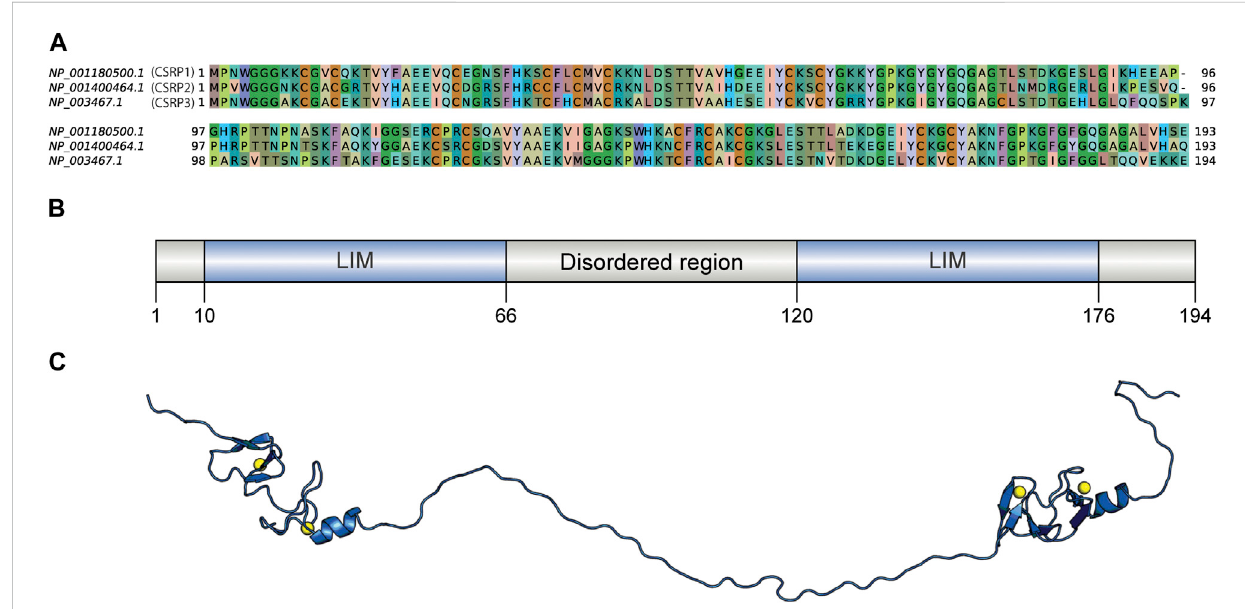
FIGURE 1 Sequence comparison of human CSRPs homologs and the CSRP3 model structure. (A) Sequence alignment of CSRP1, CSRP2, and CSRP3 proteins. (B) Domain architectureofhuman CSRP3aspredictedbythePFAM database.Itconsists oftwoLIMdomainsconnectedbyadisordered linkerregion. (C) Full length model structure of human CSRP3 modeled by a multi-template homology-based